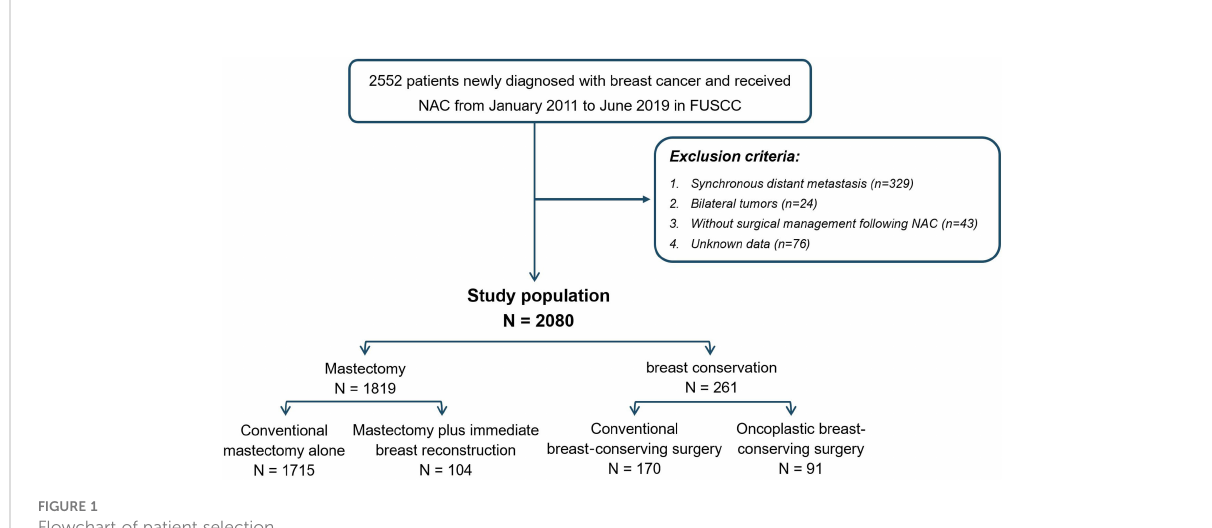
FIGURE 1 Flowchart of patient